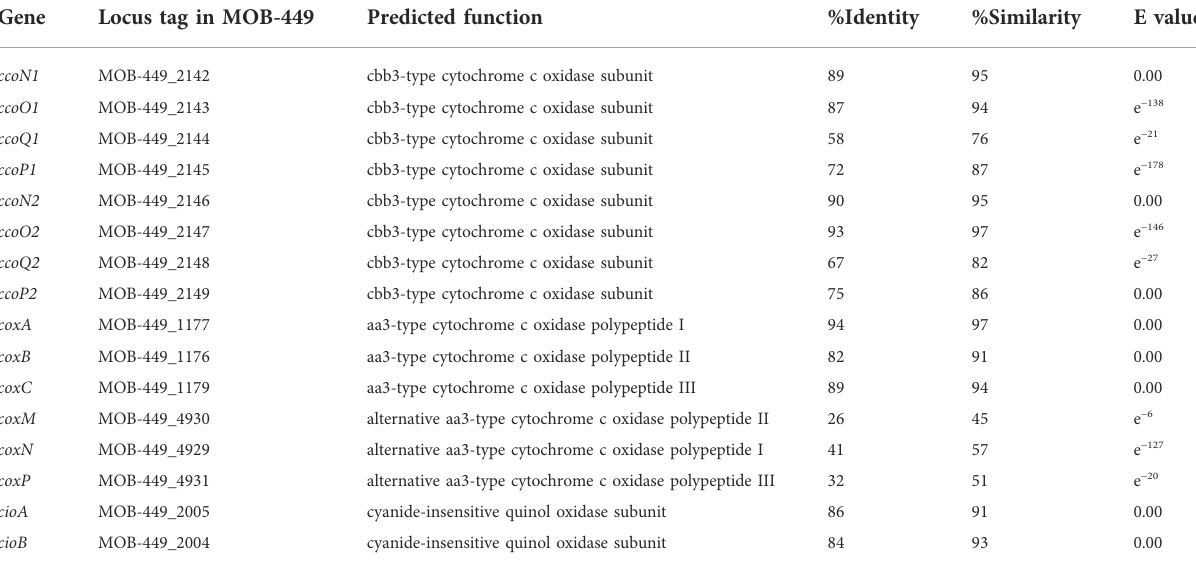
TABLE 1 List of genes in strain MOB-449 with homology to terminal oxidases from P. aeruginosa PAO1. Gene Locus tag in